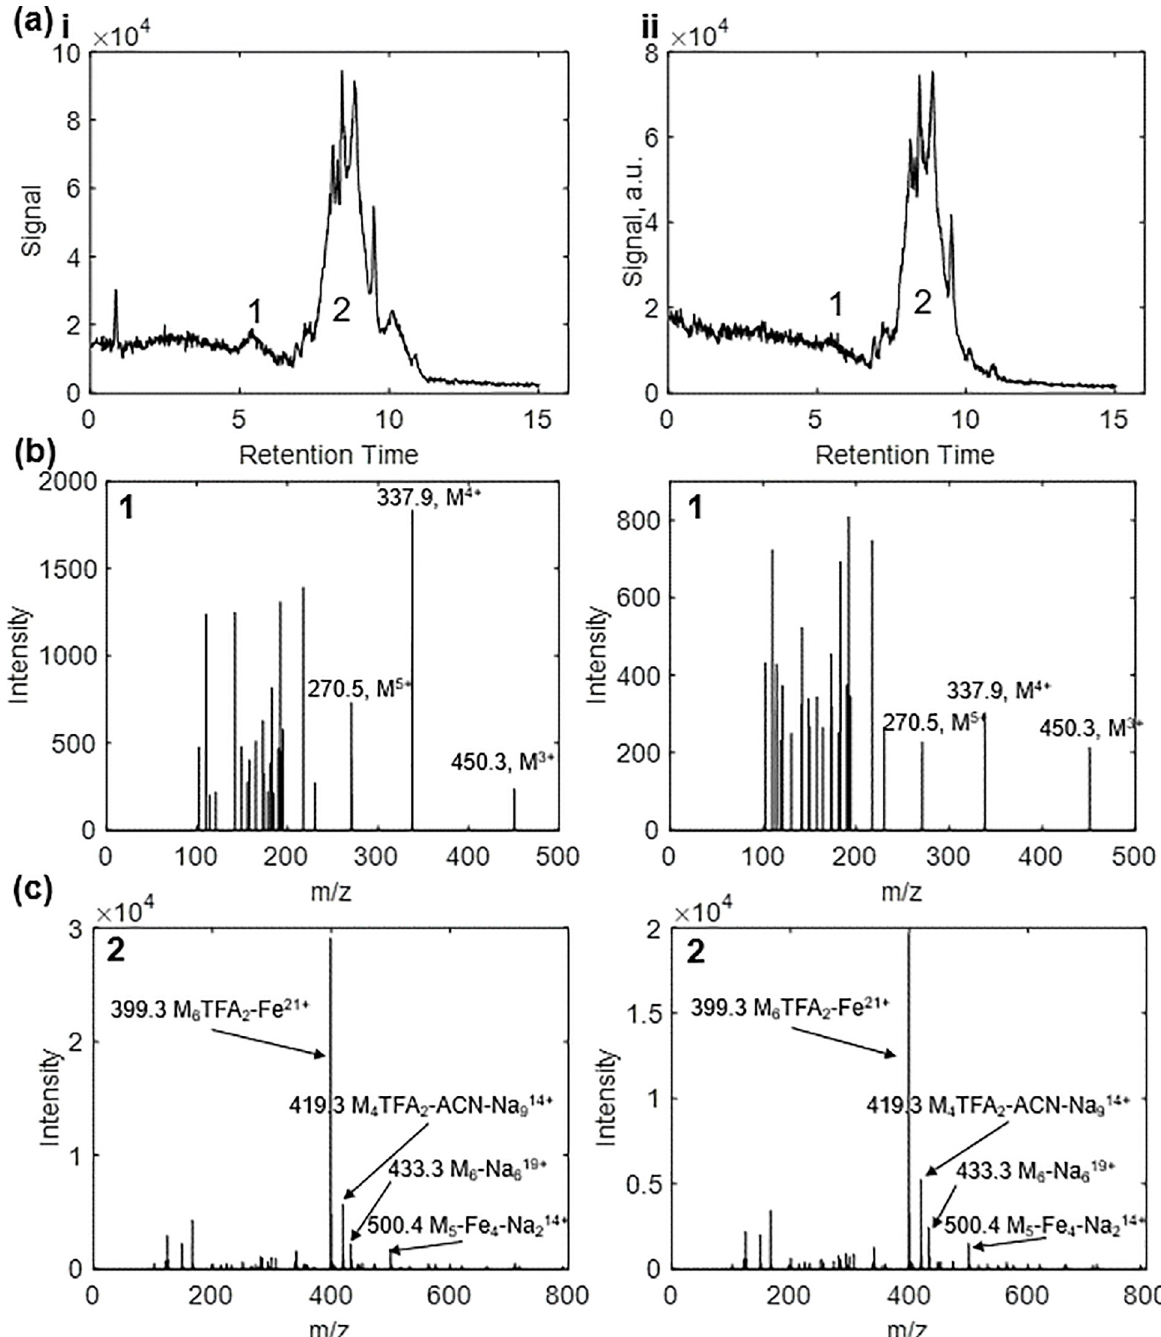
Fig 4. (a) LC spectrum of (i) frugally synthesized peptide and (ii) commercially sourced peptide standard. (1) Peptide monomer peak. (2) Peptide multimer peak. (b) ESI mass spectrum of monomer peak. (c) ESI mass spectrum of multimer peaks. Mass spectrum peaks are labelled with m/z values and proposed ions, “M” denoting the peptide